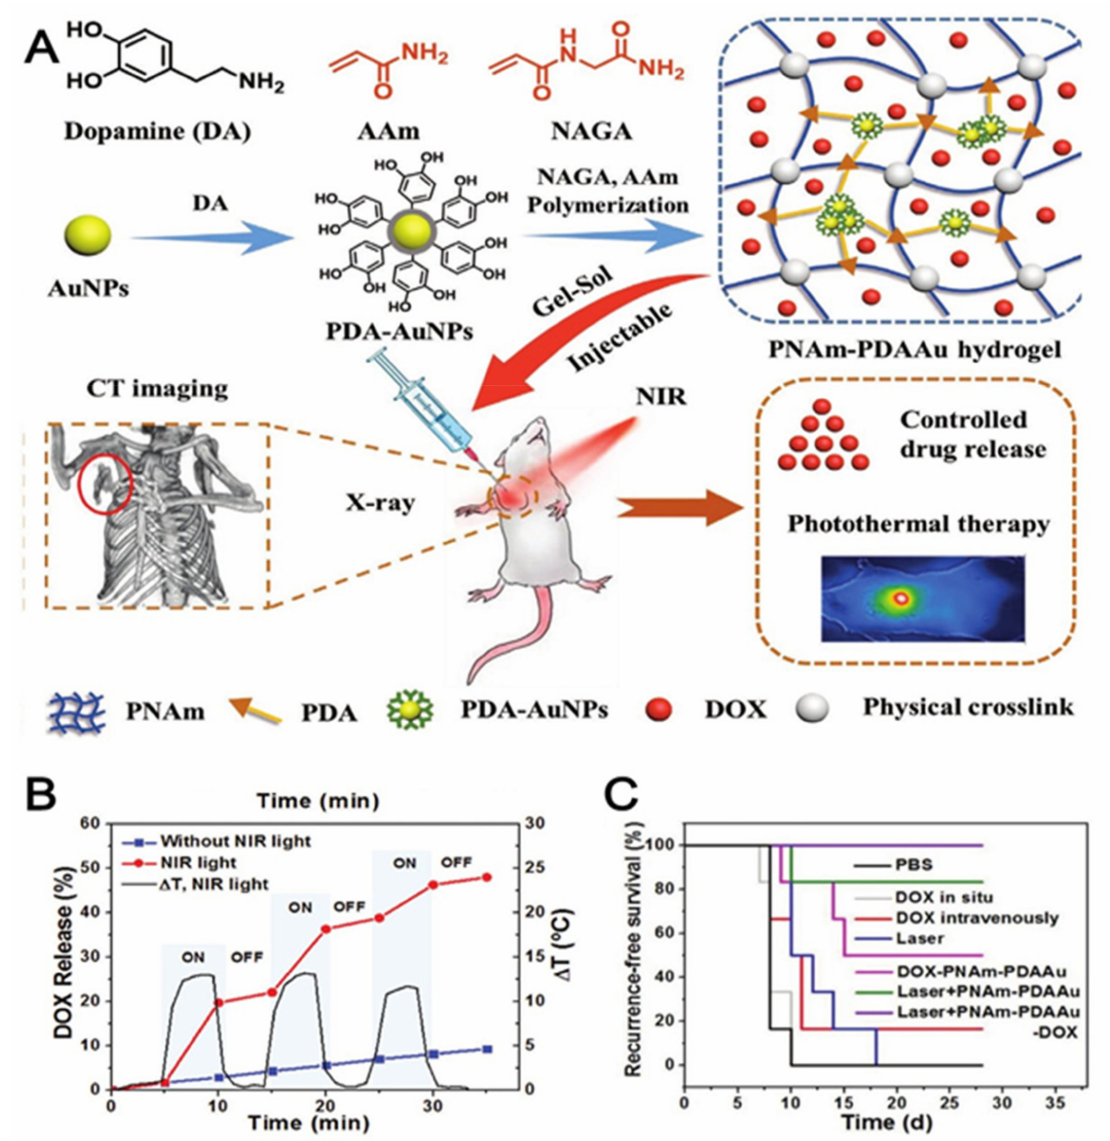
Figure 6. ( A ) PDA-AuNPs and nanocomposite PNAm–PDAAu hydrogel fabrication procedure and their theranostic application. ( B ) Photo triggered temperature increase and release of DOX from the PNAm–PDAAu hydrogel with and without NIR light irradiation. ( C ) In vivo breast cancer lo- coregional recurrence. PNAm—poly(N-acryloyl glycinamide-co-acrylamide); PDA—polydopamine. Reprinted with permission from ref. [68]. Copyright 2018 John Wiley and